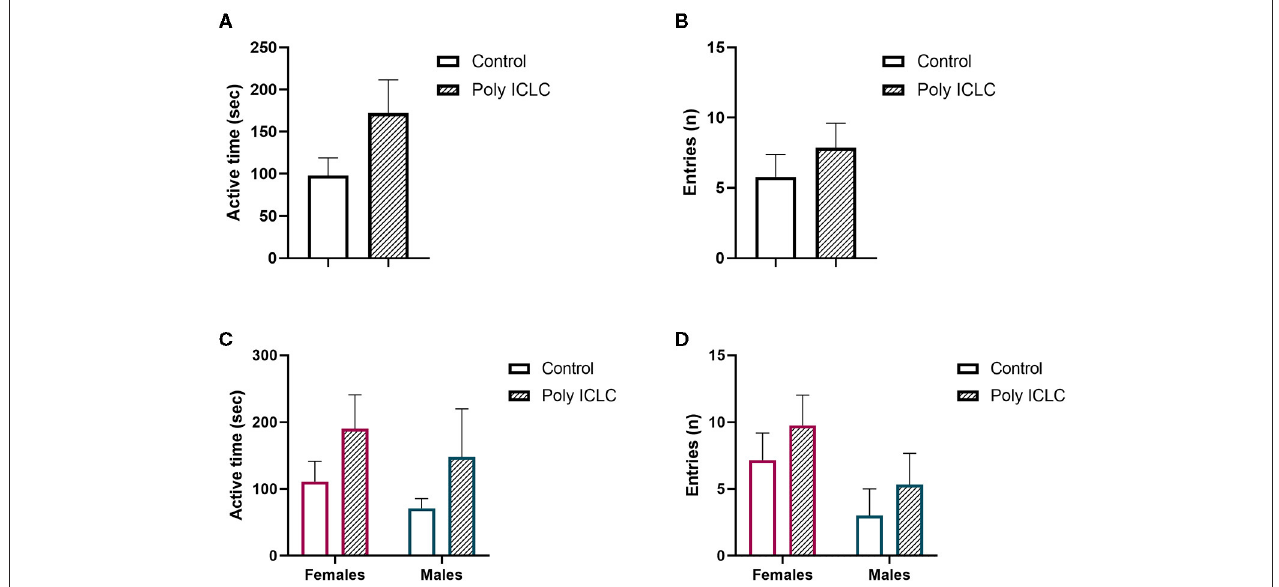
FIGURE 8 | Offspring activity during habituation (A,C) total active time during 20min of recordings. (B,C) Number of entries performed by offspring during recording. (A,B) Data pooled from females and males. (C,D) Data represented by sex. Control female n = 6, Poly IC females n = 4, Control males n = 3, Poly IC males n = 3. Data are expressed and mean ±